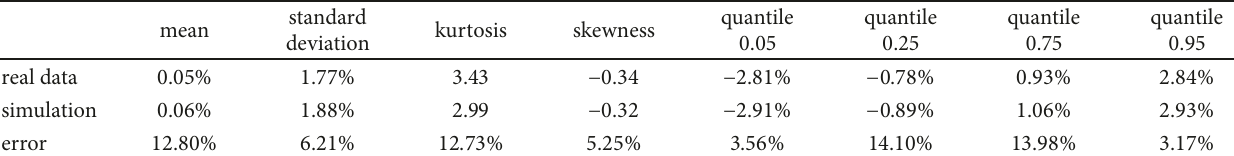
Table 3: Comparing statistical properties of the empirical data and simulated data.